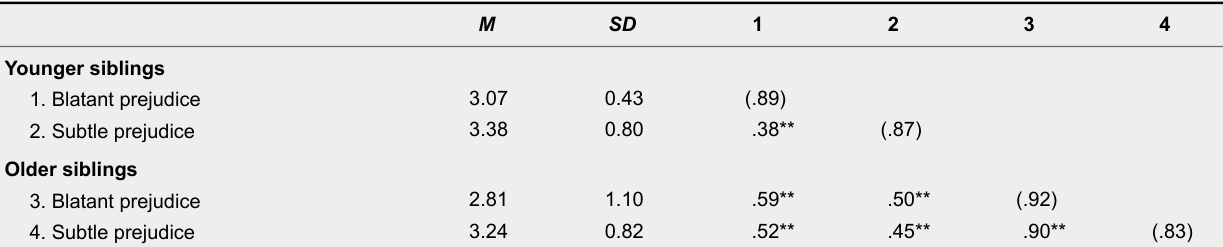
Means, SD, Cronbach α and Pearson Correlations of Blatant and Subtle Prejudice, Divided Between Older and Younger